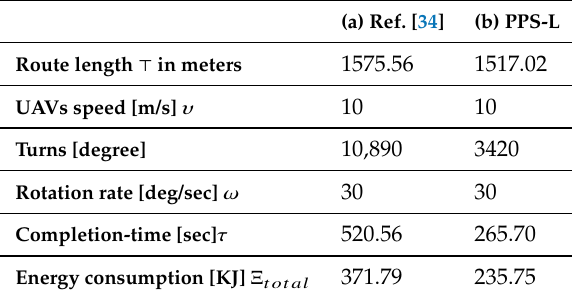
Table 14. CPP path provided in Ref. [34] vs. our